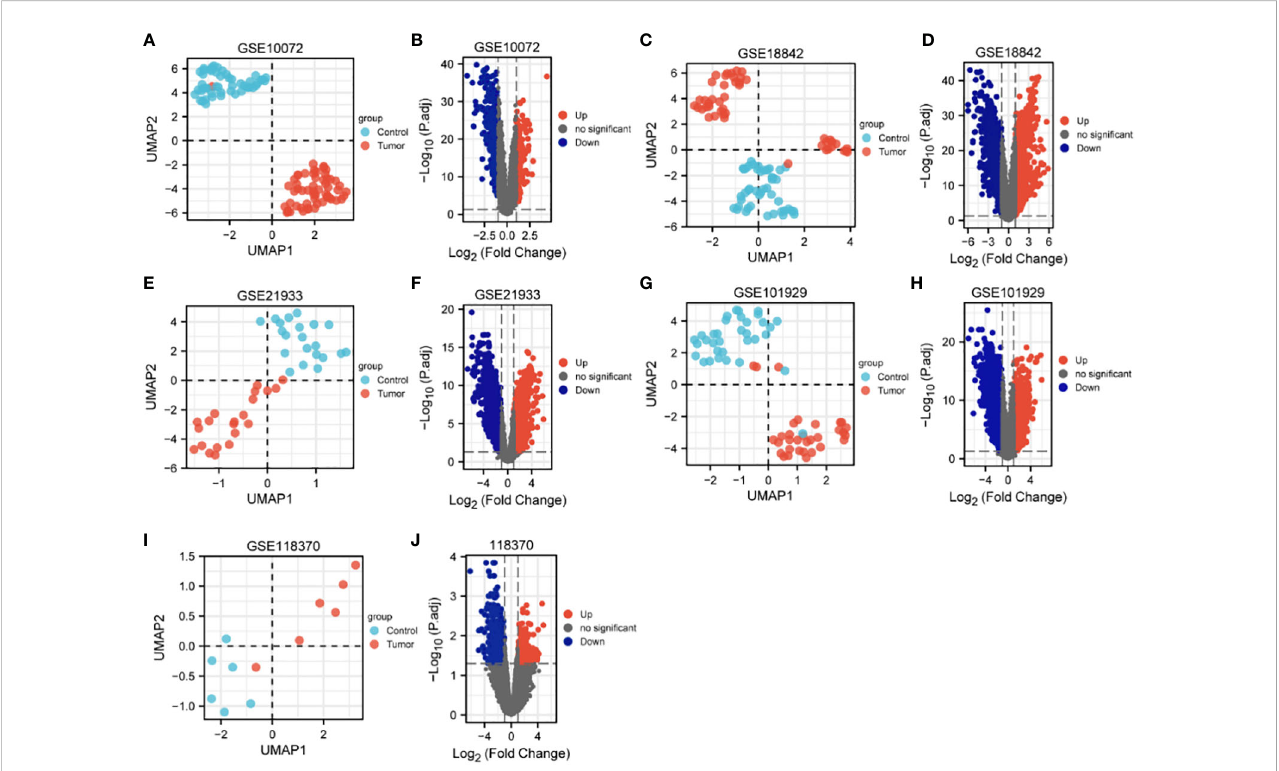
FIGURE 2 UMAP and volcano maps of the fi ve GSE datasets (log2 (FC) |>1| and p.adj<0.05). (A, B) GSE10072, (C, D) GSE18842, (E, F) GSE21933, (G, H) GSE101929, and (I, J)